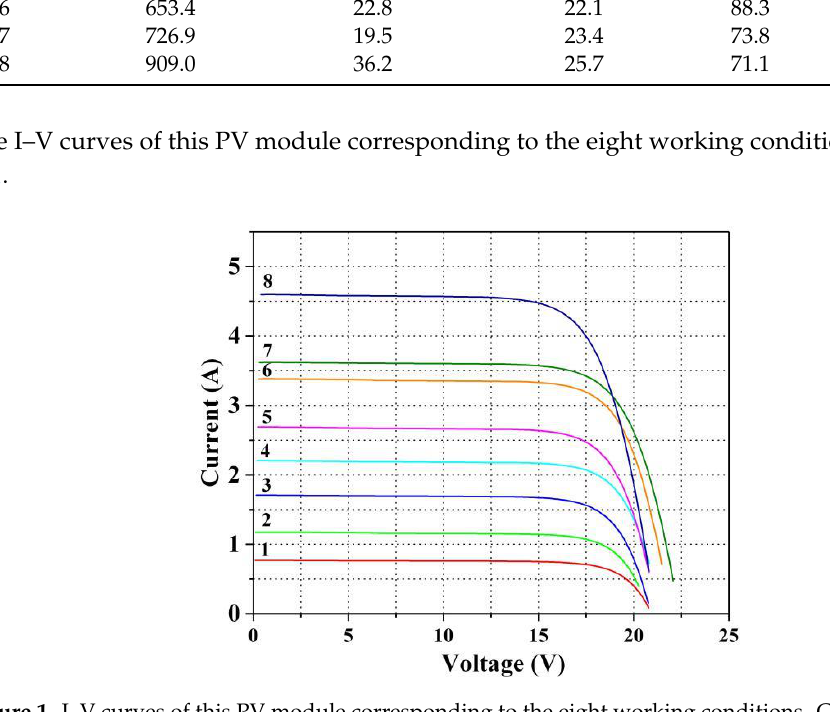
Figure 1. I–V curves of this PV module corresponding to the eight working conditions. Curve of 1–8 in the Figure correspond to the eight working conditions shown in Table 1, respectively.